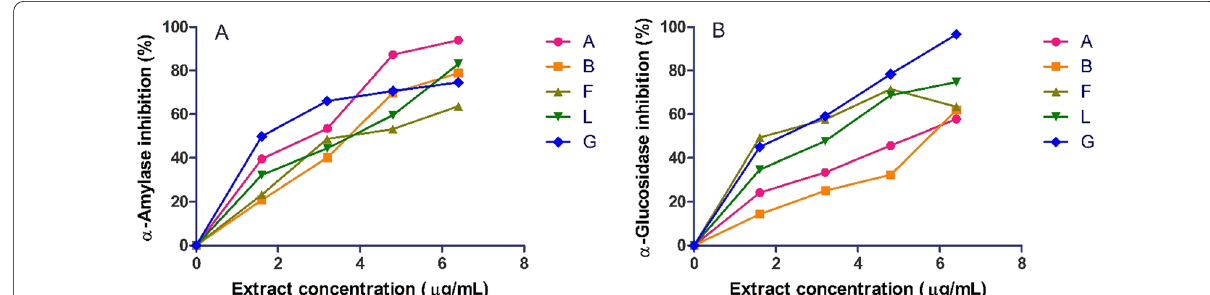
Fig. 2 α-Amylase and α-glucosidase inhibition of corn silk–lemon and commercial tea infusion. A (α)-amylase inhibitory activity. Absorbance of the mixture of infusion dilution, sodium phosphate buffer (pH 6.9 with 0.006 M NaCl) containing Hog pancreatic α-amylase and 1% starch solution in 0.02 M sodium phosphate buffer (pH 6.9 with 0.006 M NaCl) was read at 540 nm using a spectrophotometer. The percent α-amylase inhibition was plotted against five samples extract concentration (ug/ml). The percentage (%) enzyme inhibitory activity of the phenolic extracts was calculated as described by Worthington et al. (2003). B (α)-glucosidase inhibitory activity: The infusion dilution, α-glucosidase solution, phosphate buffer (pH 6.9). The mixtures were incubated at 25 °C for 5 min, and absorbance read at 405 nm in the spectrophotometer. The α-glucosidase inhibitory activity expressed as percentage inhibition and plotted against five samples extract concentration (ug/ml). The percentage (%) enzyme inhibitory activity of the phenolic extracts was calculated (Apostilidis et al. 2007). A: 100% CSF; B: 95% CSF and 5% LF; F: top tea; L: lipton tea; G: green tea; CSF: corn silk